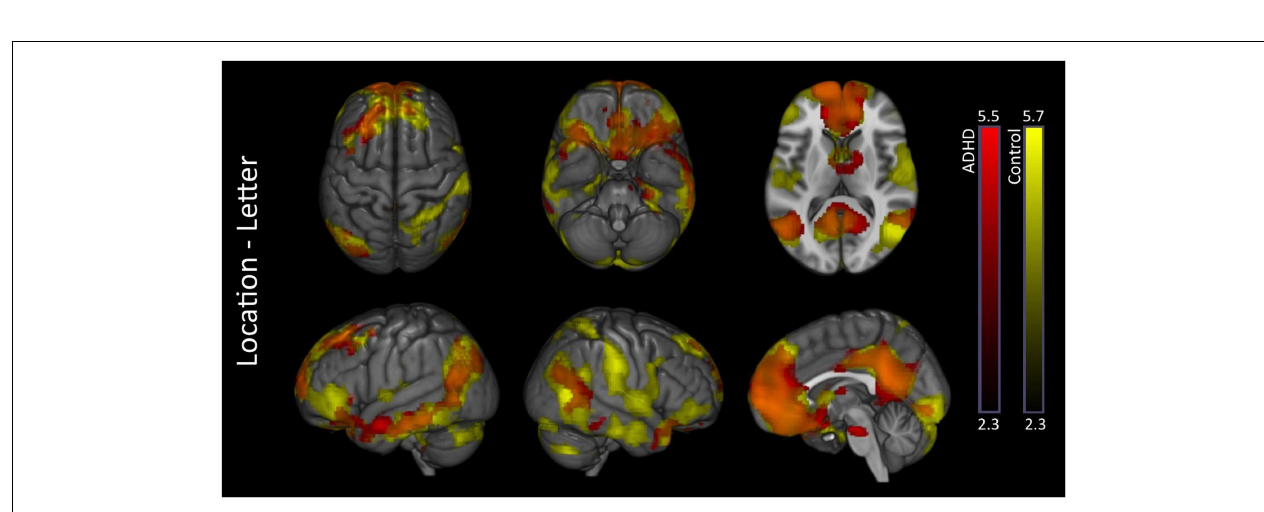
FIGURE 2 |Task conditions–baseline: within-group effects . Within-group analysis of BOLD signal revealed unique LH occipital activations in controls (yellow) and unique RH occipital activations in ADHD subjects (red). Several common activations were also evident (orange), such as LH, supplementary motor, pre-central gyrus (superior lateral,